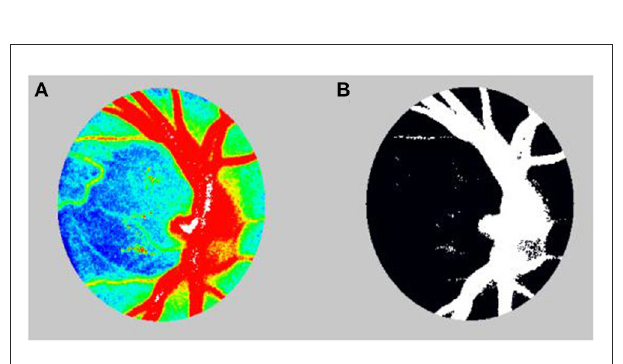
FIGURE2 (A) Color-coded map before calculating the area ratio of the blood stream (ARBS). (B) In calculation of the ARBS, the vessels were separated using the automated definitive